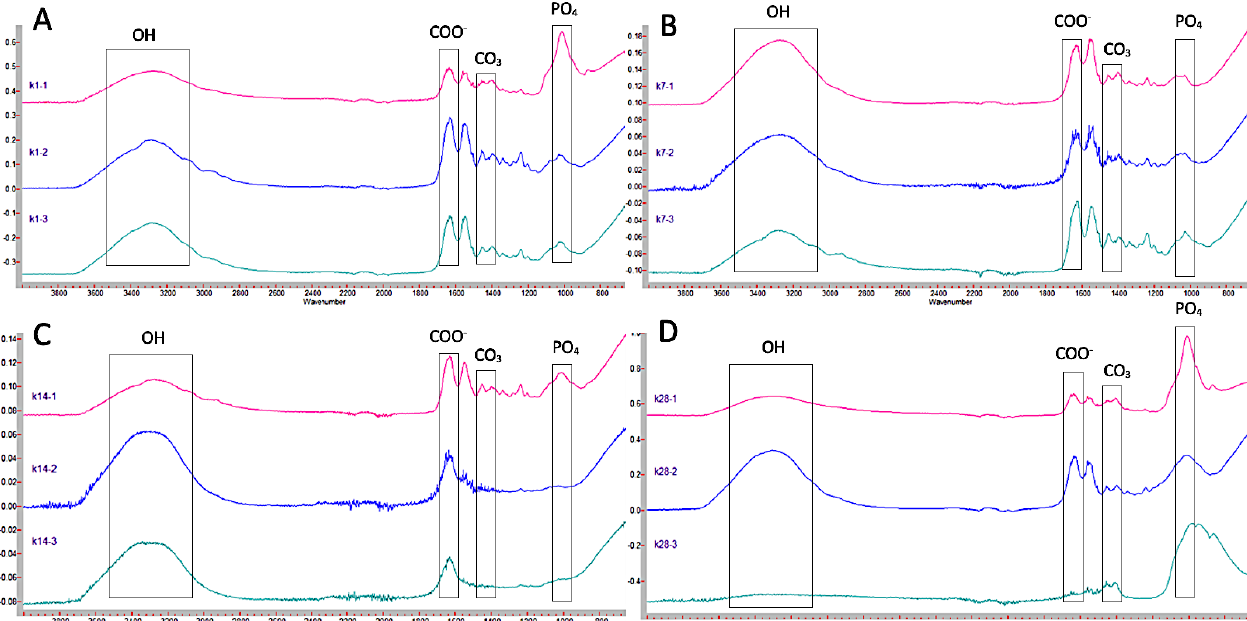
Figure 4. Comparison of Ketac Molar FTIR spectra at different thicknesses (1, 2, and 3 mm) at 24 h ( A ), 7 days ( B ), 14 days ( C ), and 28 days ( D ). The peaks of the OH, COO − , CO 3 , and PO 4 groups of interest in this study are indicated.